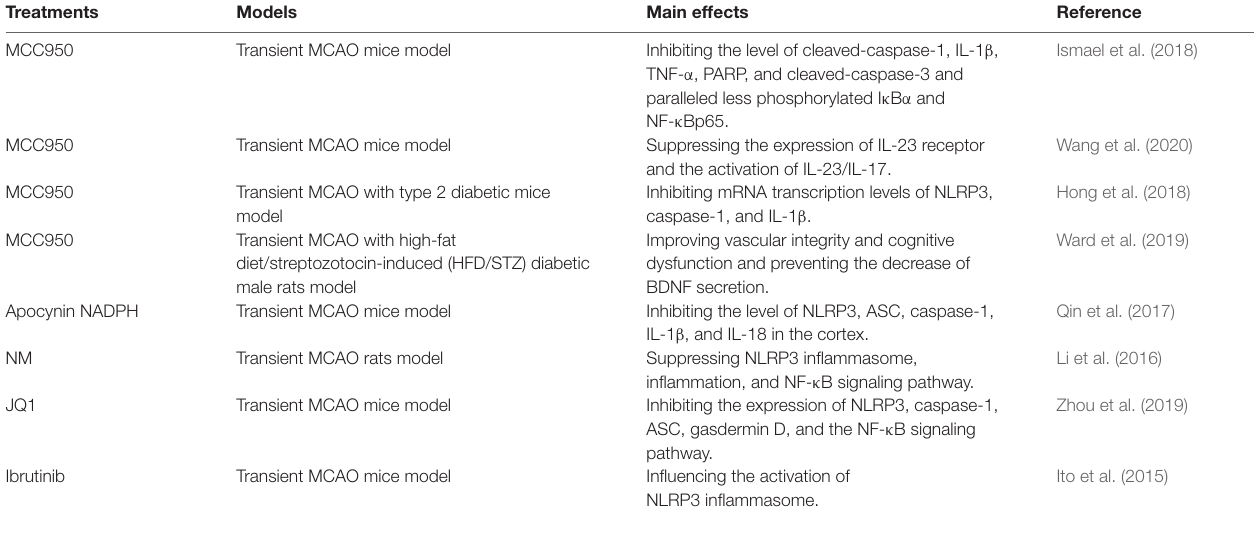
TABLE 1 | Several molecular inhibitors via inhibiting NOD-like receptor pyrin domain containing 3 (NLRP3) inflammasome in ischemic stroke.